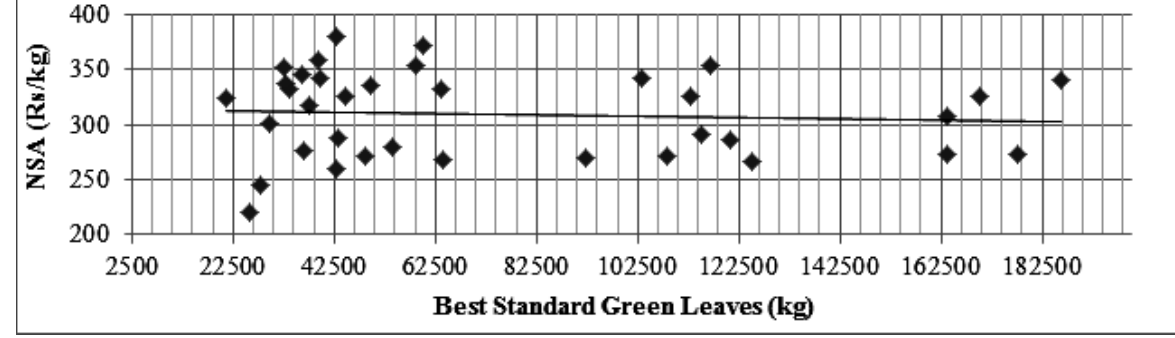
Fig 17: Relationship of Best Leaf Quantity with NSA in Udu Pussellawa Uva Unlike in other regions, Uva has showed negative relationship for the main grade percentage and NSA (see fig 18). And it was concentrated to 60 to 75 percentages and as in other regions, Uva show low price variation for main grades.